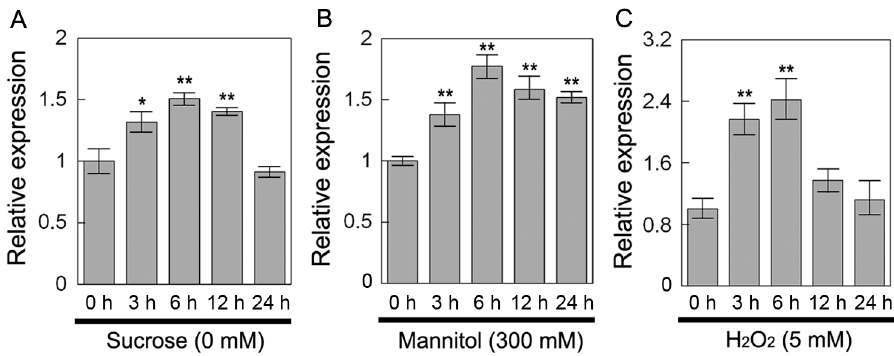
Figure 2. Expression of DsSWEET12 . Expression analysis of DsSWEET12 under sucrose starvation and other various stresses. One-week-old D. spiculifolius seedlings were treated with ( A ) sucrose starvation (0 mM), ( B ) mannitol (300 mM), ( C ) and H 2 O 2 (5 mM) for 0, 3, 6, 12, and 24 h. DsActin was used as an internal control, and the transcript level in the untreated seedlings was set as 1.0. Asterisks indicate significant difference between untreated and stress-treated seedlings (* p < 0.05; ** p < 0.01; Student’s t test). Error bars show the SD of the values from three replicates.